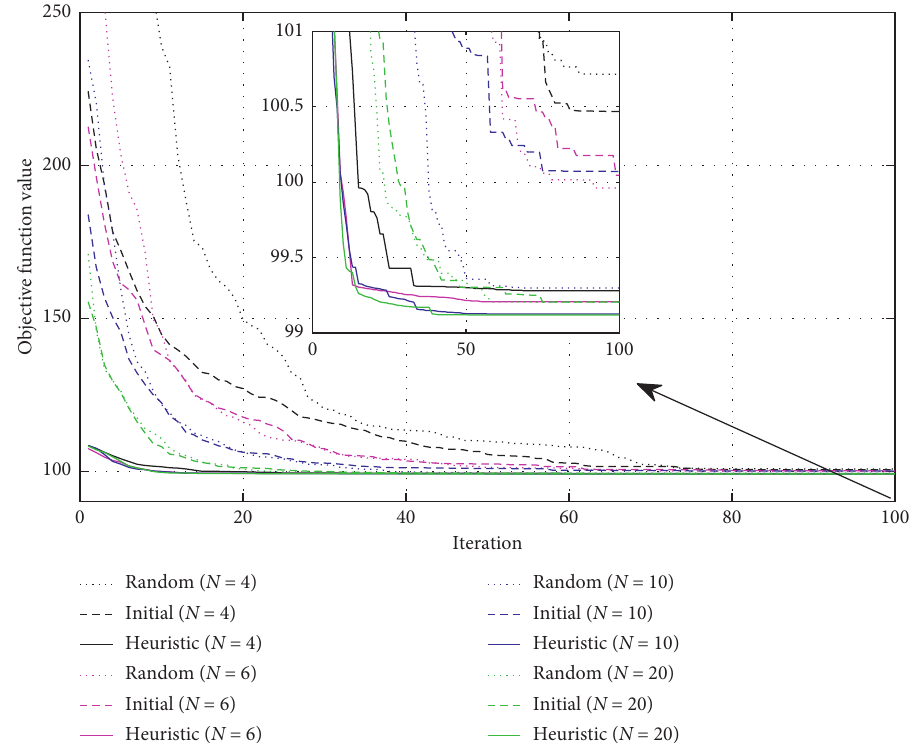
Figure 12: Mean convergence curves of three initialization methods with different population sizes for the 69-node